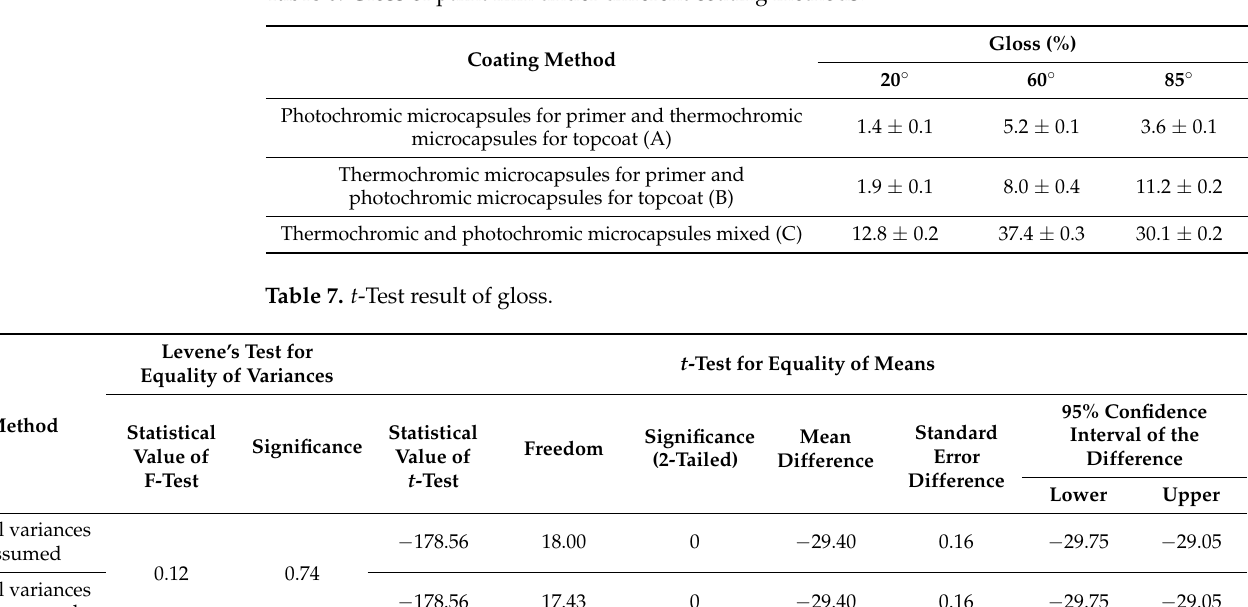
Table 6. Gloss of paint film under different coating methods.